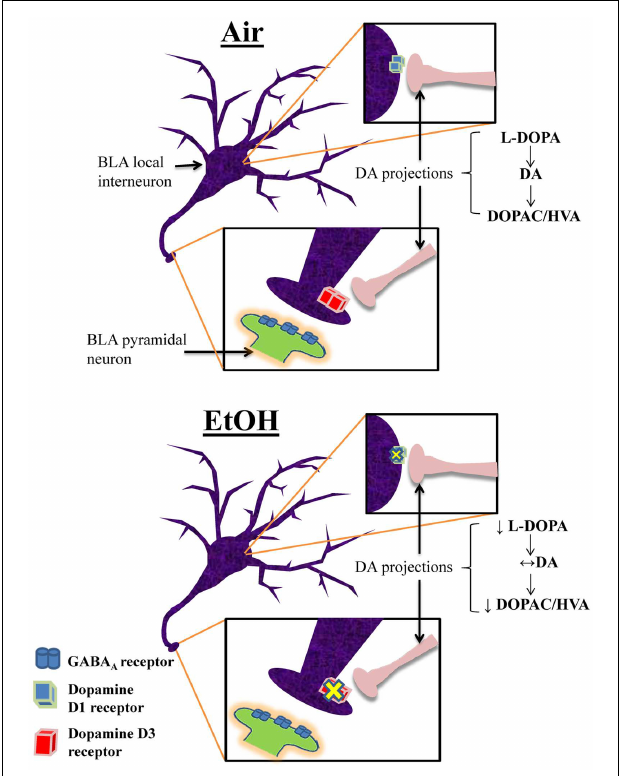
FIGURE 7 | Proposed model of the effects of third trimester-equivalent ethanol exposure on dopamine function in the BLA .The top panel illustrates a local GABAergic interneuron inhibiting a pyramidal neuron in the BLA (postsynaptic pyramidal neuron dendrite only shown in zoomed in image). DA projections from the ventral tegmental area innervate local interneurons, releasing DA onto D1Rs and D3Rs (the exact location of DA innervation onto these local interneurons is unknown). In Air-exposed animals, D1R activation increases interneuron firing, resulting in increased action potential-dependent spontaneous GABA release. Conversely, D3R activation suppresses quantal action potential-independent release of GABA from interneurons.These two opposing effects regulate the balance of GABA transmission in pyramidal neurons. In EtOH-exposed animals, D1R and D3R function is significantly blunted, without changes in receptor levels. Furthermore, although L -DOPA levels are robustly reduced, DA levels remain unchanged due to decreased degradation of DA into DOPAC and HVA.These homeostatic changes presumably explain the normal behavior observed in the elevated plus